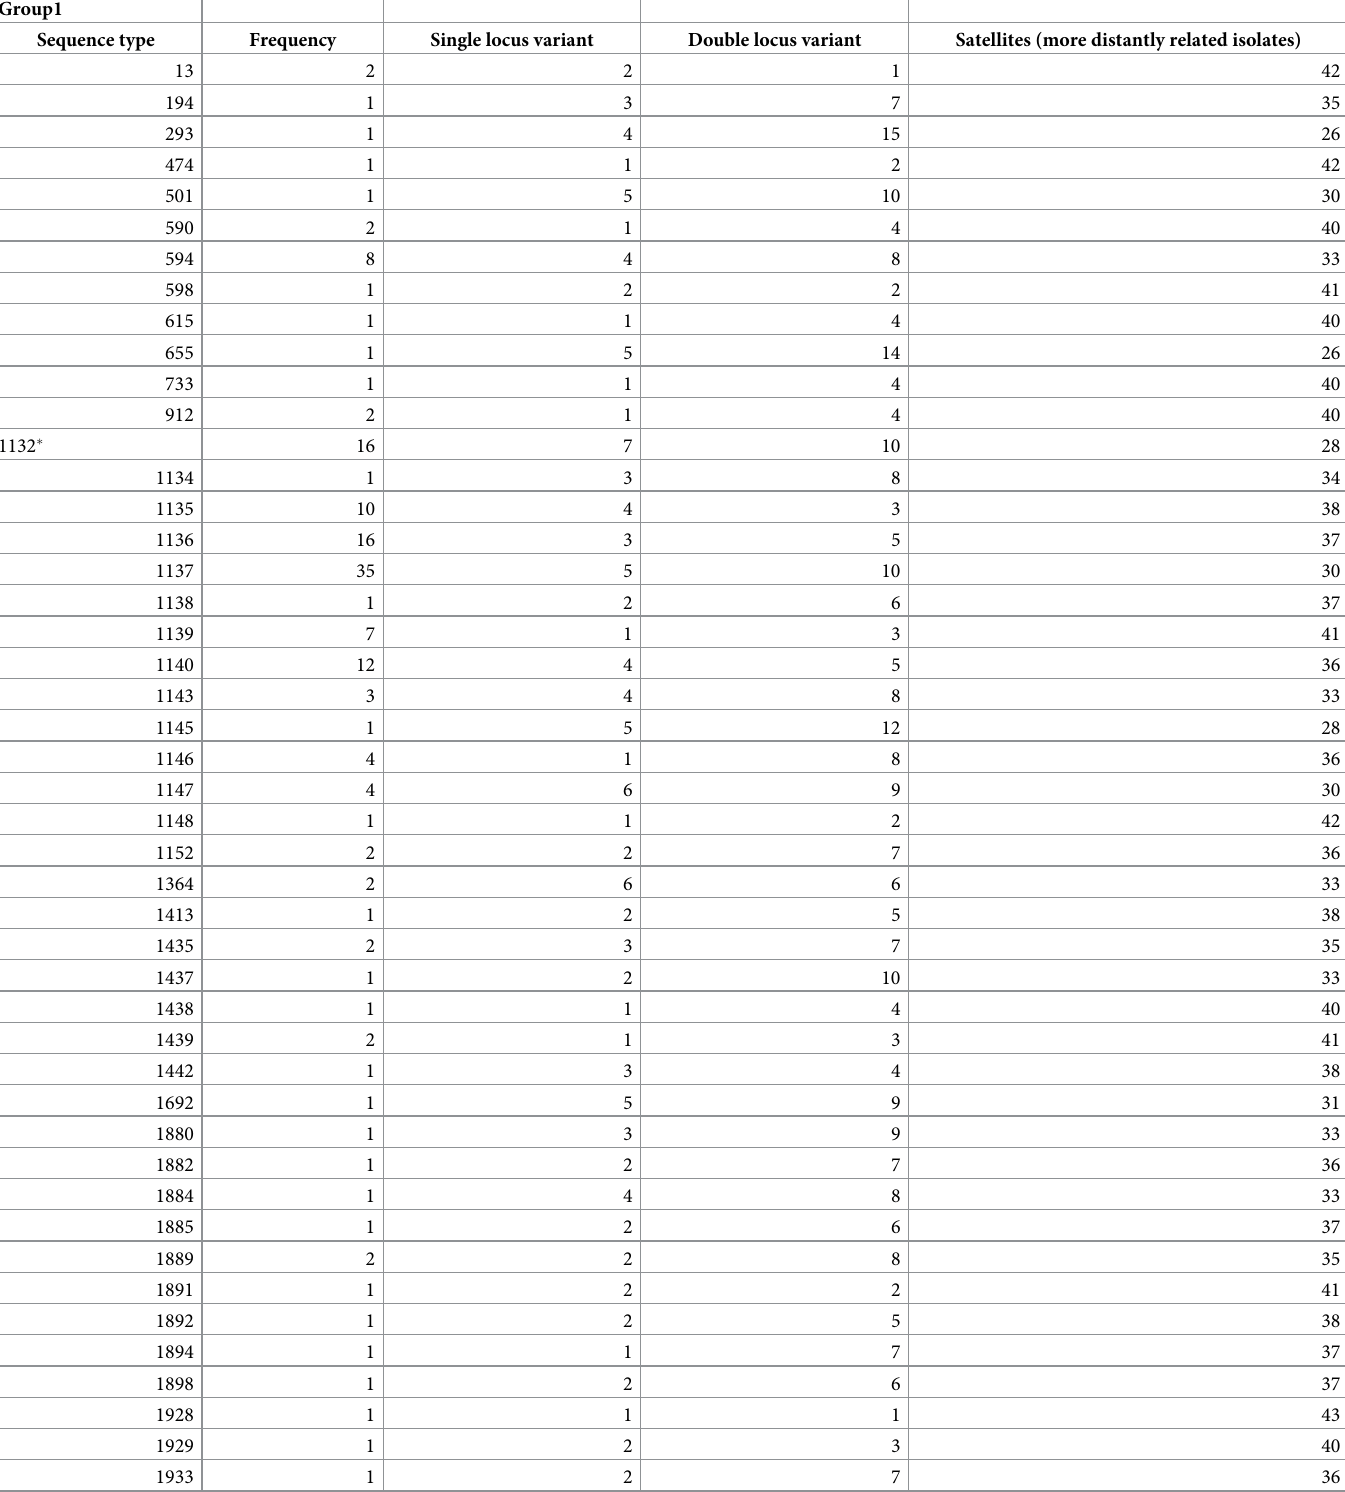
Table 3. Description of the study isolates based on eBURST analysis.